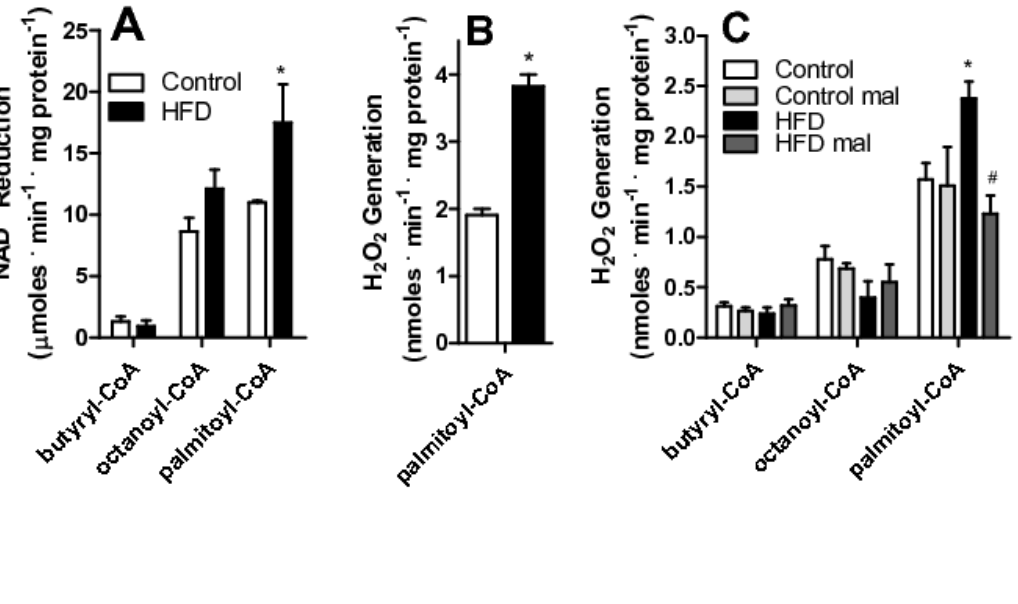
Figure 6. HFD increases ROS release from VLCAD. (A) Frozen and defrosted mitochondria (0.5 mg protein. mL -1 ) were incubated in 150 mM KCl, 2 mM MgCl , 1 mM EGTA, 1 mM KH PO , 10 mM Hepes, 0.1% BSA, pH 7.4. Alamethicin (0.5 μg/mL), 2 2 4 0.5 ng/mL antimycin A, 1 µM rotenone and 50 µM NAD + were added to the incubation media, and NADH fluorescence was monitored as described in Materials and Methods in the presence of 50 μM butyryl-CoA, octanoyl-CoA or palmitoyl-CoA, where indicated. (B) Frozen and defrosted mitochondria were incubated in the same media as Panel A, in the presence of 0.5 μg/mL alamethicin, 5 μM Amplex Red and 1 U/mL HRP. H O release was measured as described in Materials and Methods. (C) Fresh 2 2 mitochondria were incubated under the conditions of Figure 3, substituting succinate for 50 μM butyryl-CoA, octanoyl-CoA or palmitoyl-CoA, as shown. Where indicated, 50 µM malonyl-CoA (mal) was present. *, p < 0.05 versus control, # , p < 0.05 versus HFD in absence of malonyl-CoA, n = 6 per